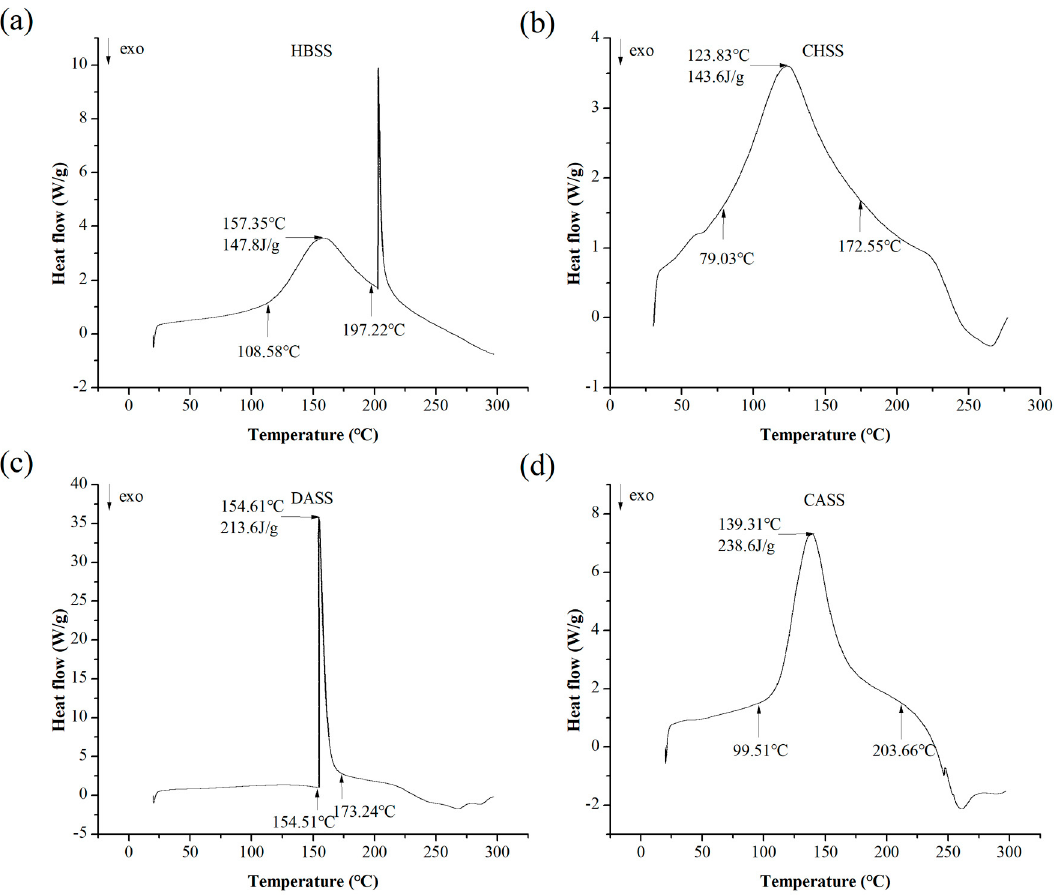
Figure 4. The differential scanning calorimetric (DSC) properties of MLPs. ( a ) HBSS; ( b ) CHSS; ( c ) DASS; ( d ) CASS.